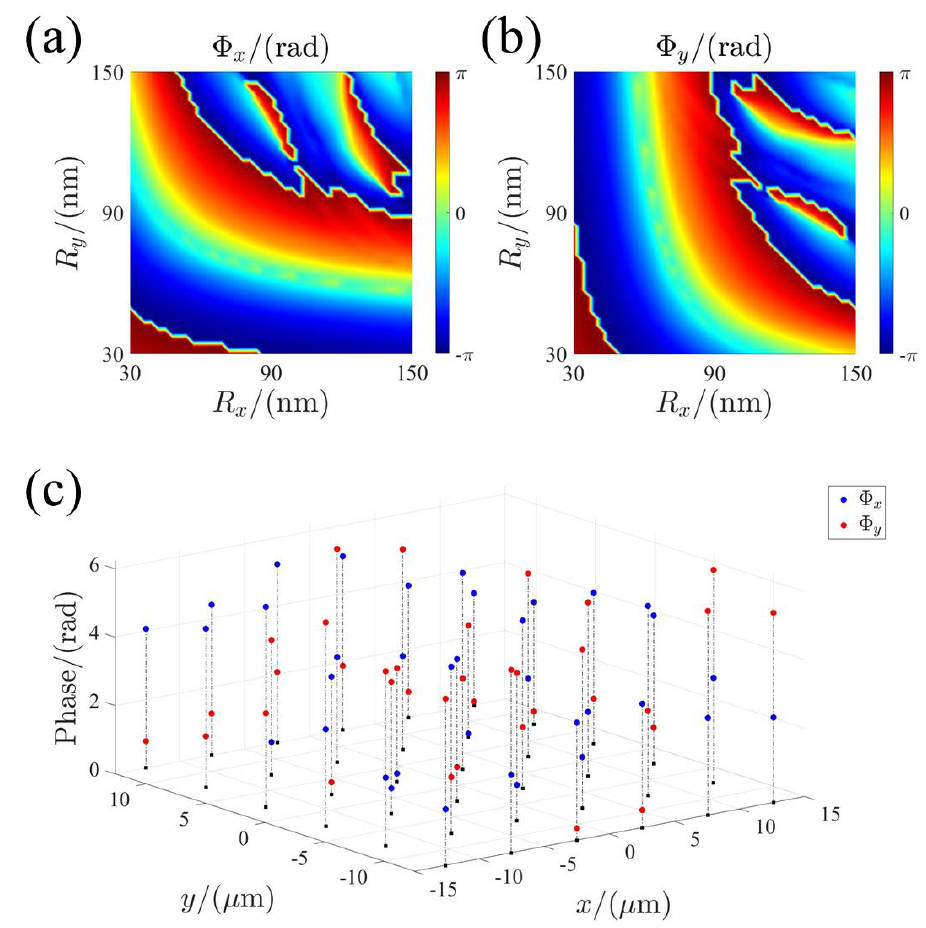
Figure 2. The library of the nano-pillars. ( a , b ) Phase shifts of the elliptical nano-pillars as a function of major axis R x and minor axis R y for x - and y-polarized incidences, respectively. ( c ) Phase shift for x - and y-polarized incidences for the selected and optimal nano-pillars used in design of the metasurface.